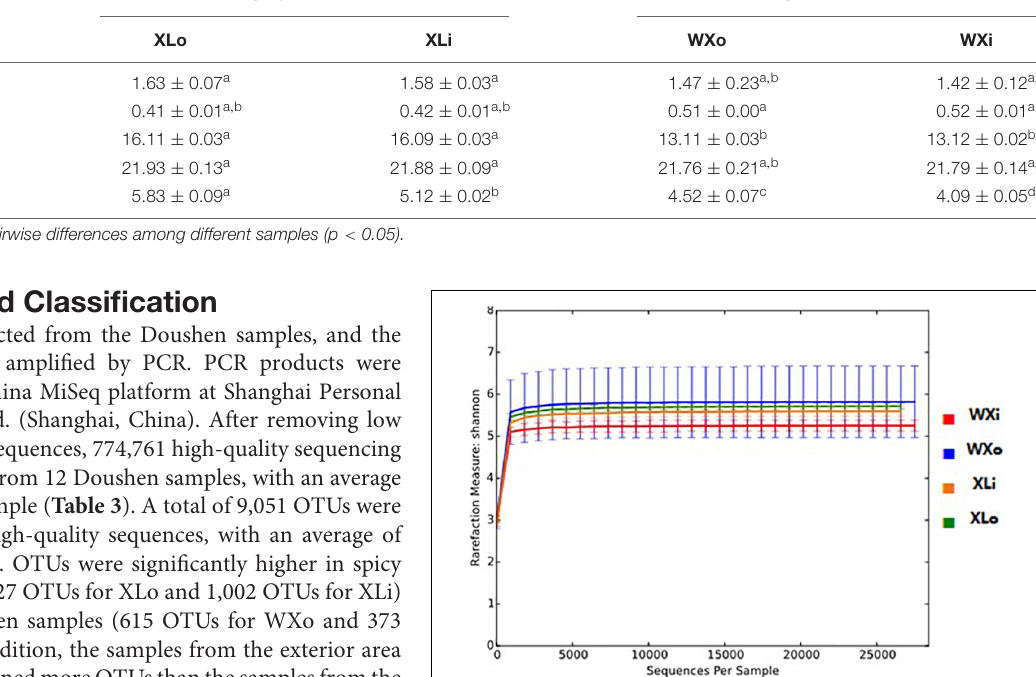
TABLE 2 | Physiocheinical characterization of Doushen and enumeration of fungi. Parameters